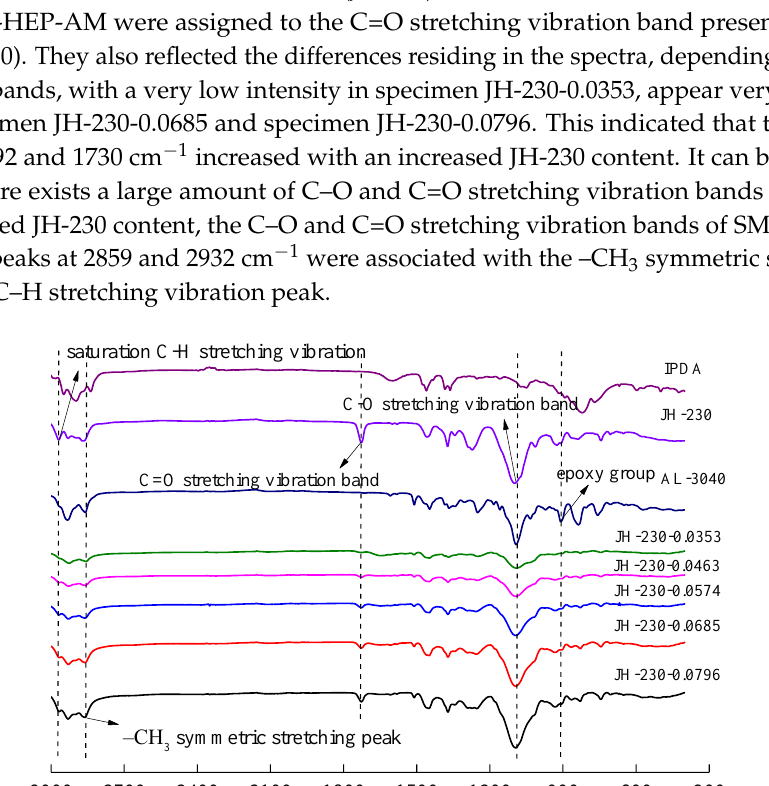
Figure 10. Dynamic mechanical analysis (DMA) curves of the SM-HEP-AM: ( a ) the storage modulus; and ( b ) the loss modulus.